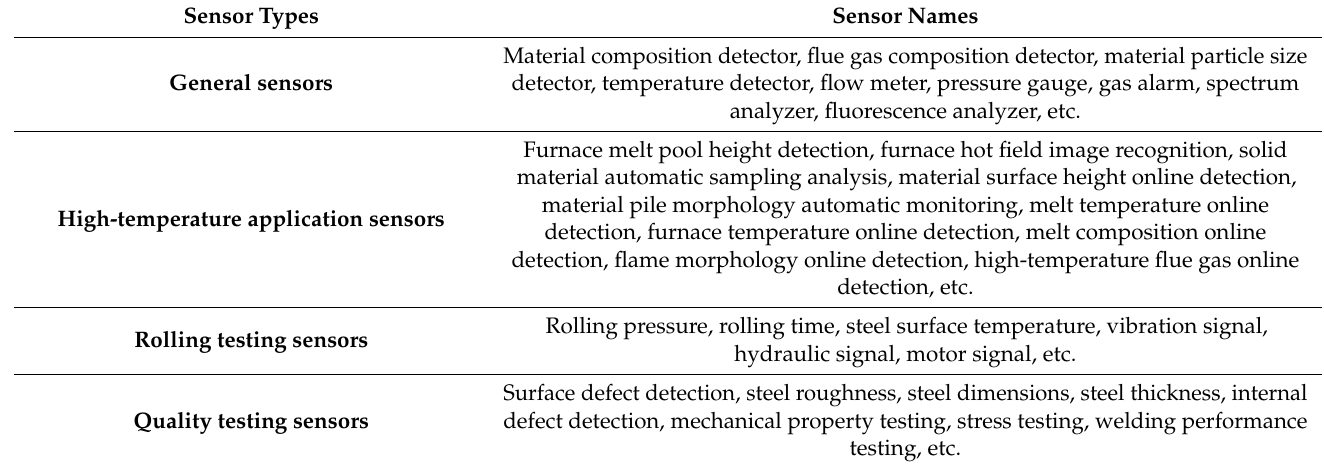
Table 2. Main sensors used for intelligent manufacturing in steel industry.